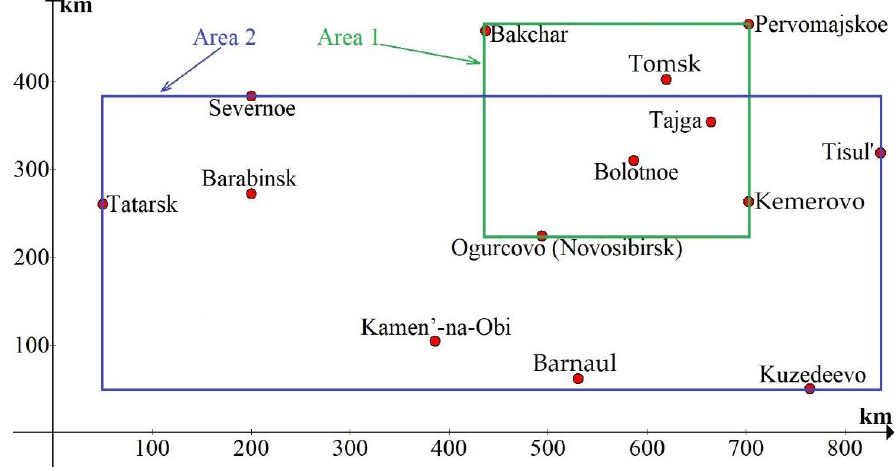
Figure 1. Position of the weather stations in the Area 1 and Area 2.